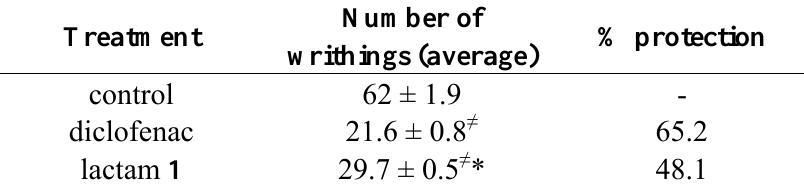
Table 1. Percentage protection in acetic acid induced writhings by diclofenac and lactam 1 in mice (dose: 100 μ mol Kg -1 ).